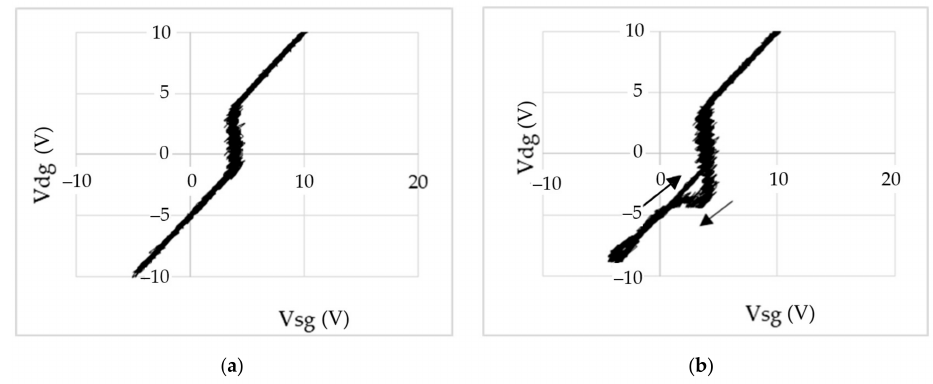
Figure 8. Result of the triangular wave on–off experiment (II) of the PMOS at ( a ) 1 kHz and ( b ) 800